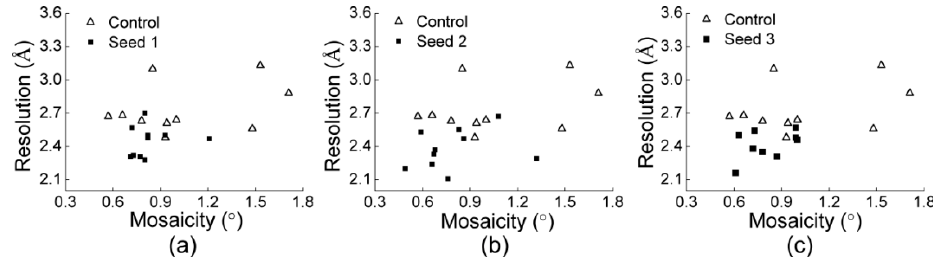
Figure 6. Combination of the resolution limit and mosaicity for the proteinase K crystals in the same Figure. ( a ) in the presence of seeds 1, ( b ) in the presence of seeds 2, ( c ) in the presence of seeds 3.